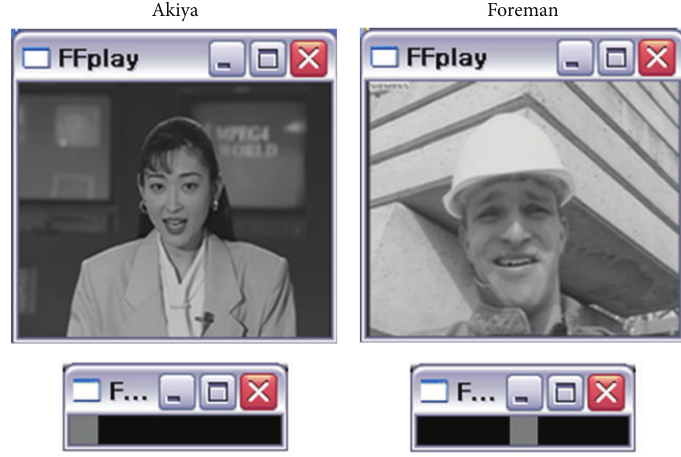
Figure 12: Contents